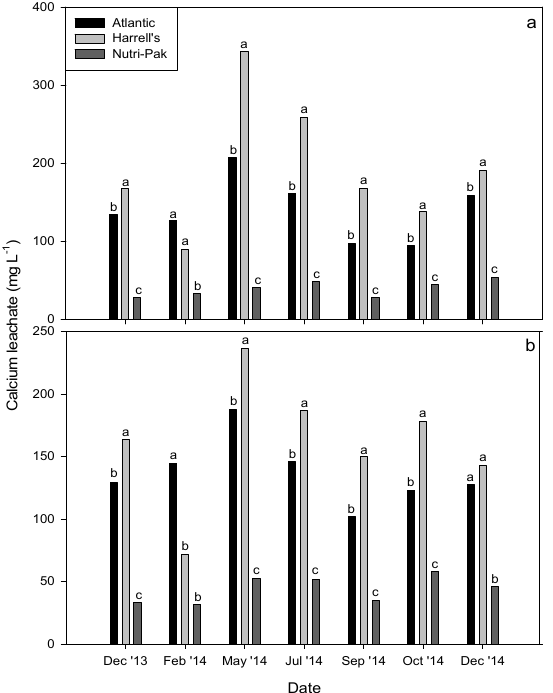
Figure 5. Calcium leached from potting medium Livistona chinensis ( a ) and Syagrus romanzoffiana ( b ) plants during 17 months of growth with Atlantic, Harrell’s or Nutri-Pak fertilizer. Letters above bars for an individual date represent mean separation by Tukey’s at 0.05